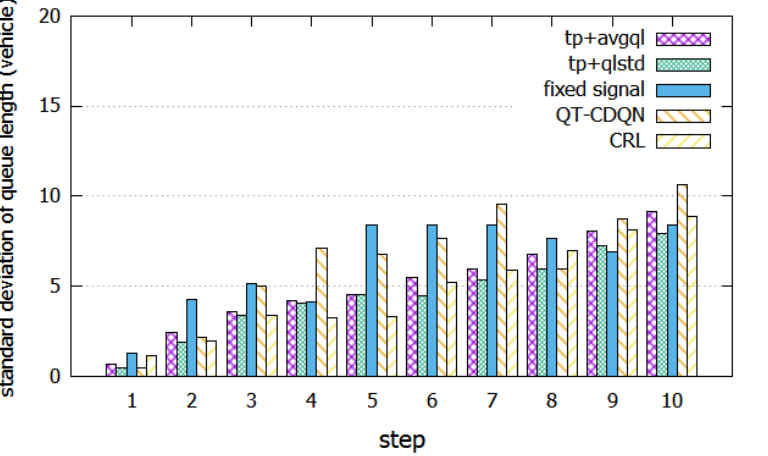
Figure 12. Performance comparison: standard deviation of queue